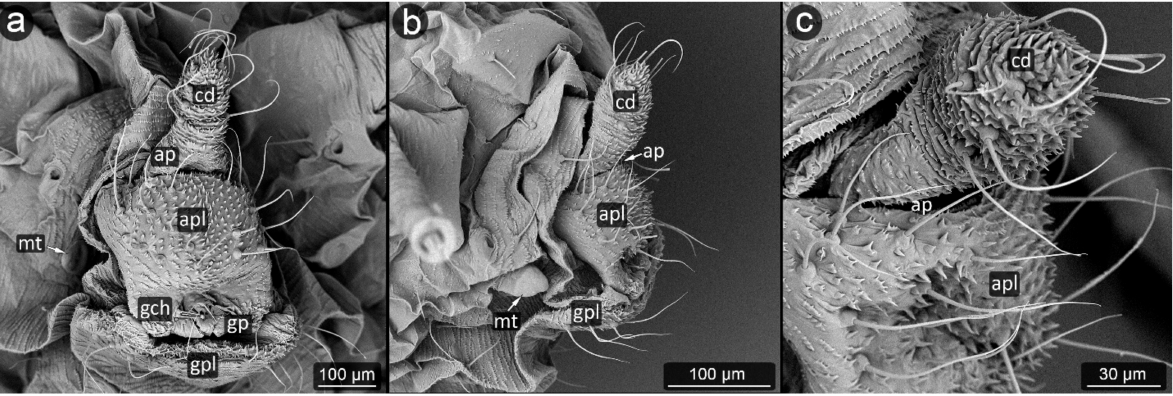
Figure 23. Perianal structure of Aphis hederae in SEM; ( a )—rear view, ( b )—lateral view, ( c )—close-up on the surface of cauda and anal plate; (gch—gonochaetae). Abdominal tergite VIII: covered with transverse rows of minute spinules; two setae on both